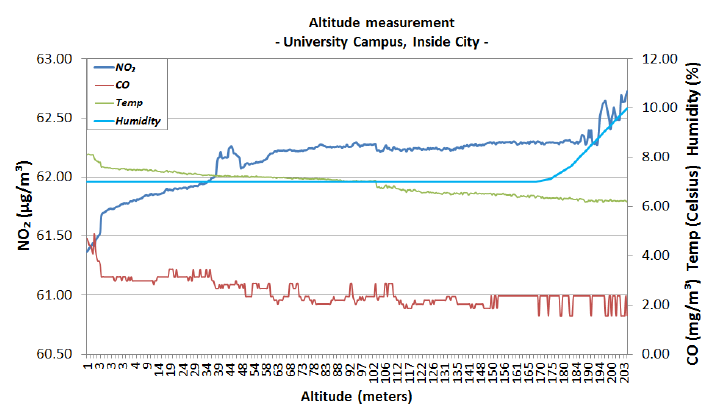
Figure 9. University area, sunny day, autumn, 200 m